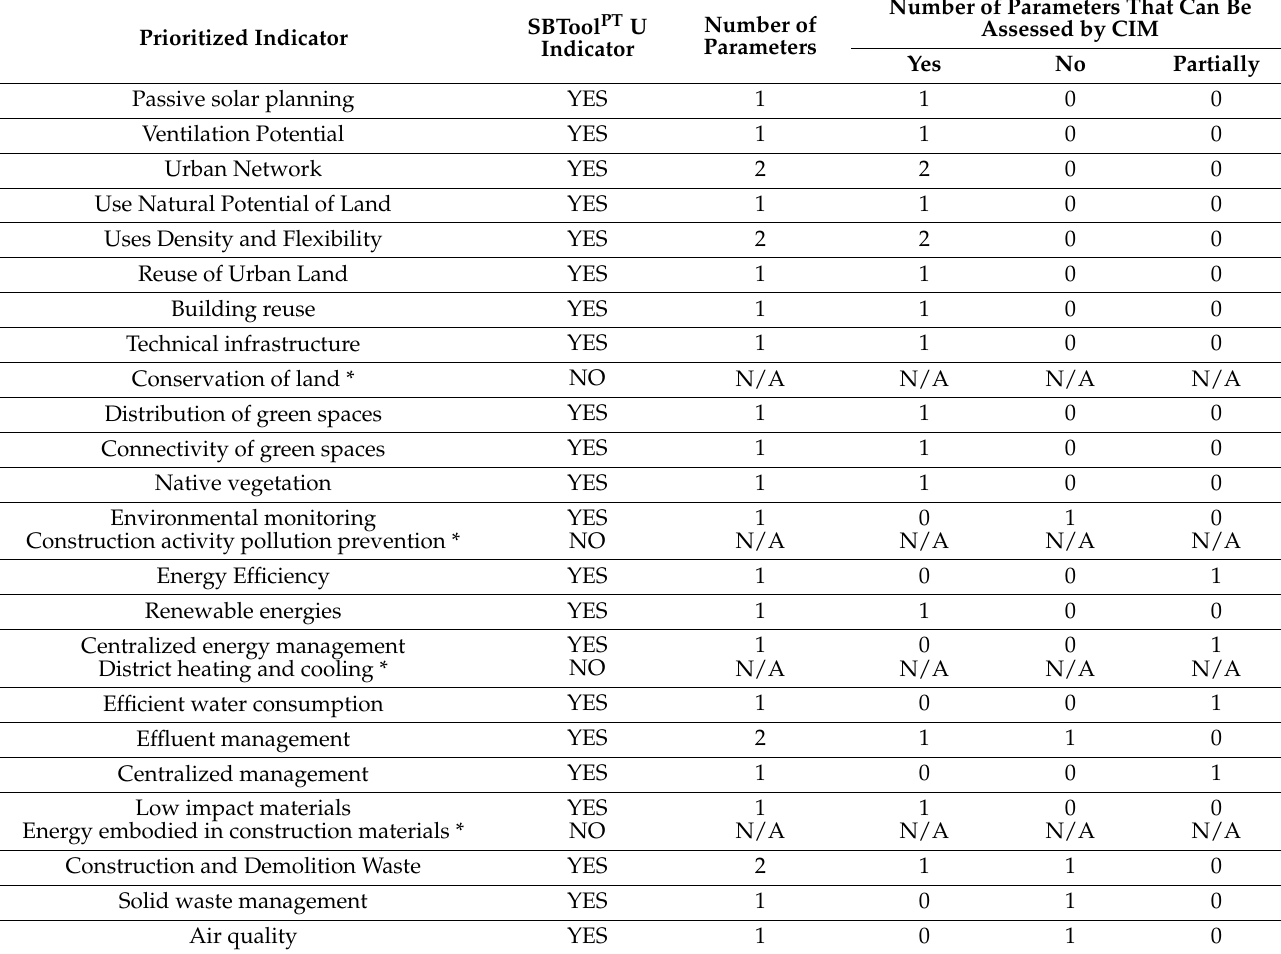
Table 1. Classification of